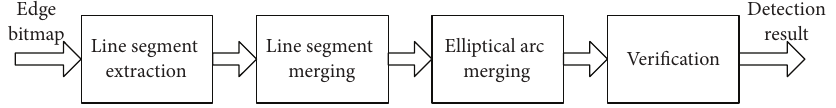
Figure 2: Block diagram of the proposed method.